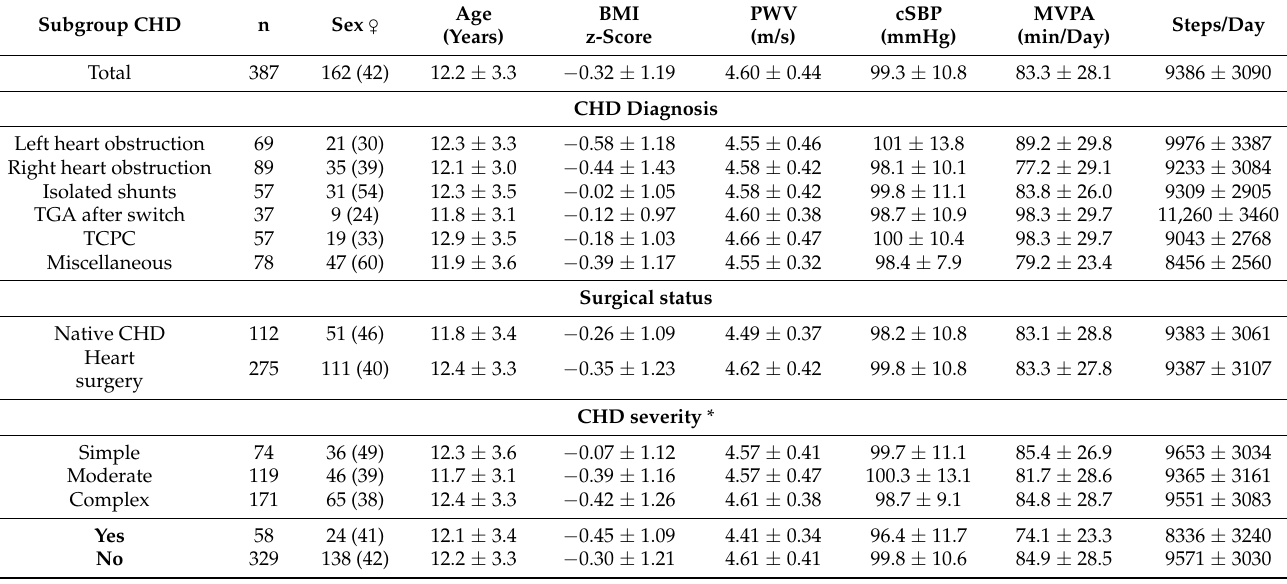
Table 1. Population characteristic of children with congenital heart